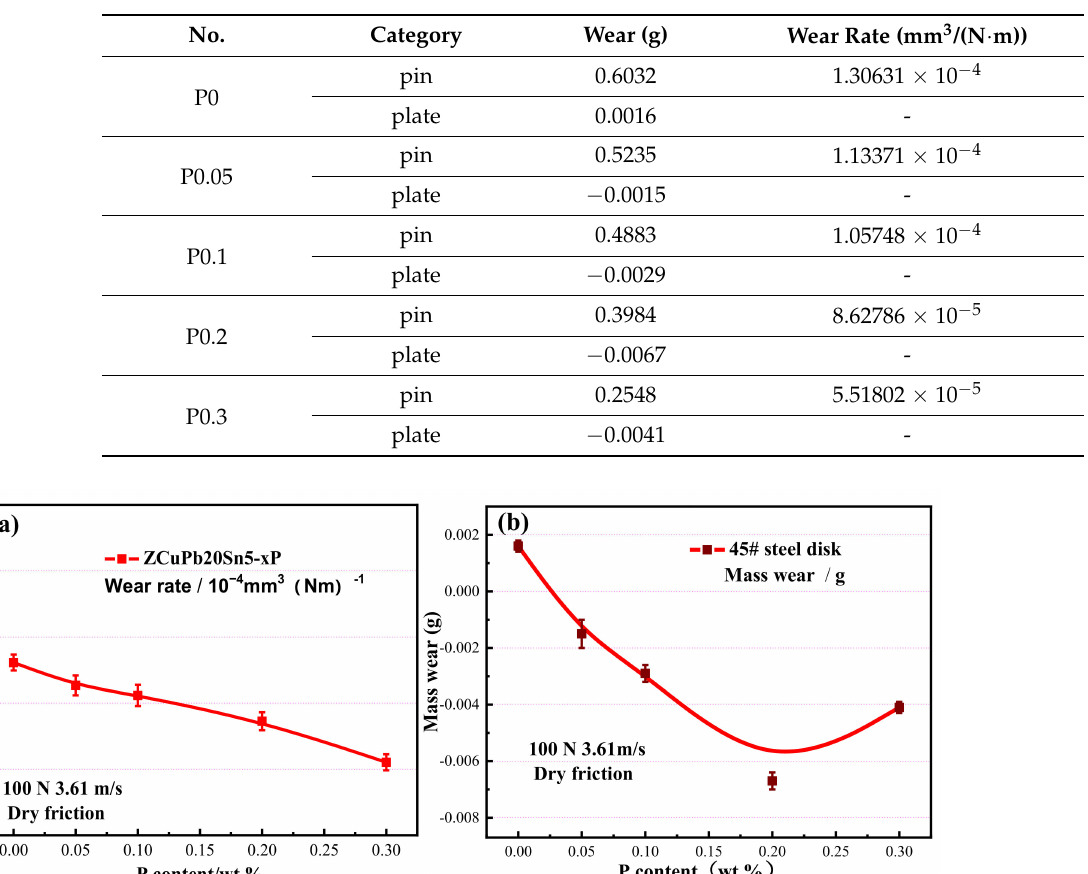
Table 2. Wear rates of ZCuPb20Sn5 alloys with different P contents under dry friction.